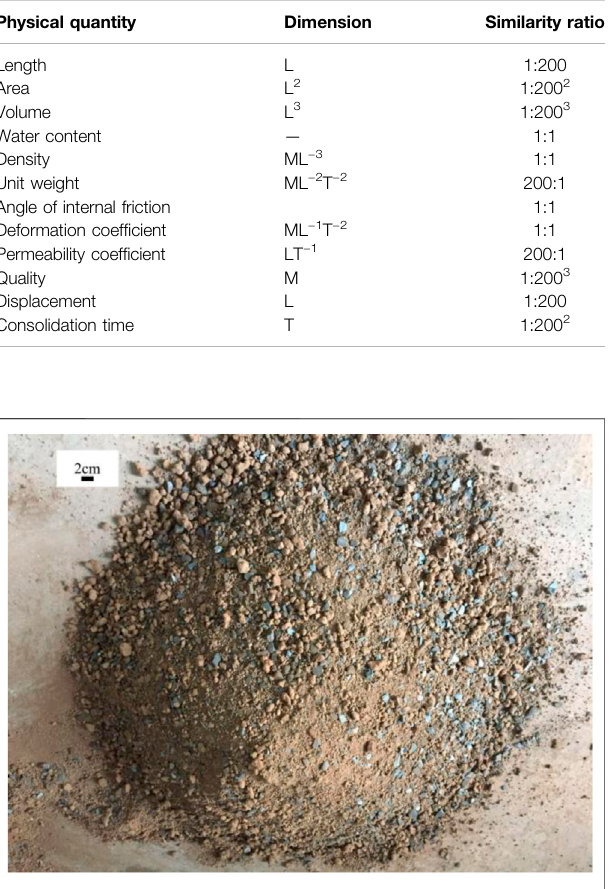
TABLE 1 | Physical quantity similarity ratio of the centrifuge model.